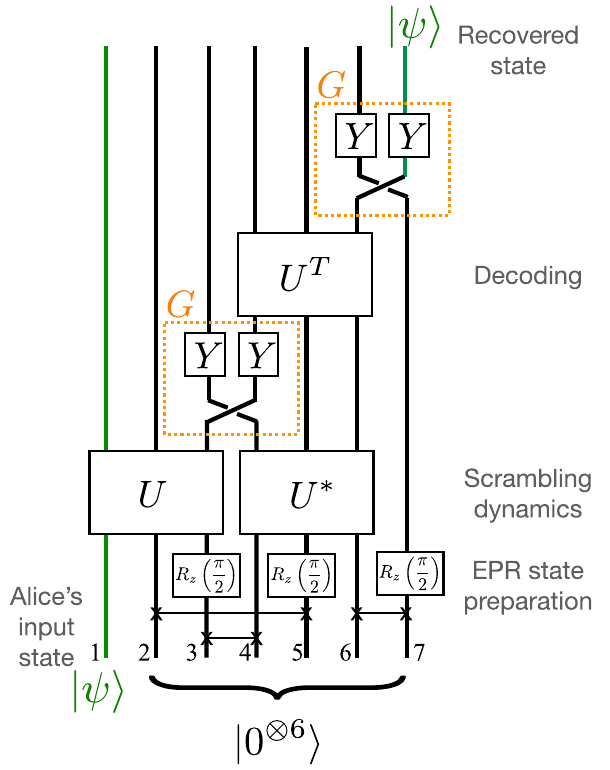
Fig. 13 Simulating the many-body teleportation protocol in the lab [98]. A qubit inserted in the left system is decoded on the right. The quantum circuit is drawn vertically here for convenience and to relate to the protocol in Fig. 7. A horizontal line ending in two crosses is the Mølmer–Sørensen gate, exp ( − i π